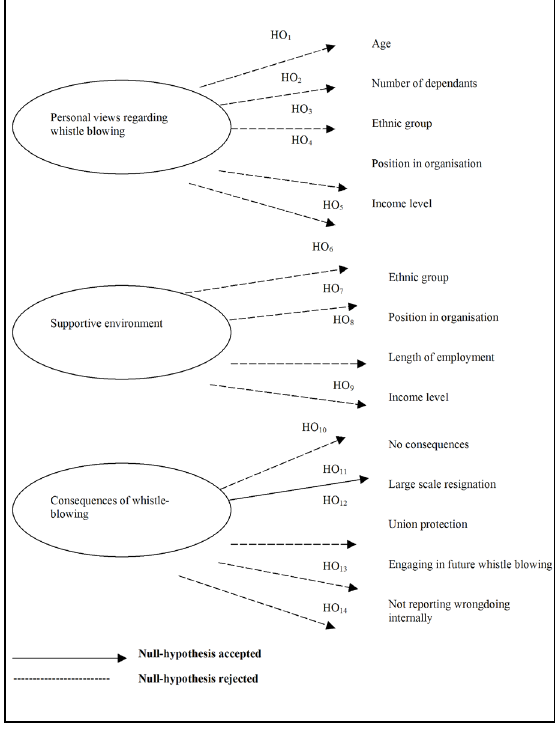
figure 2 Summary of Hypothesis Testing